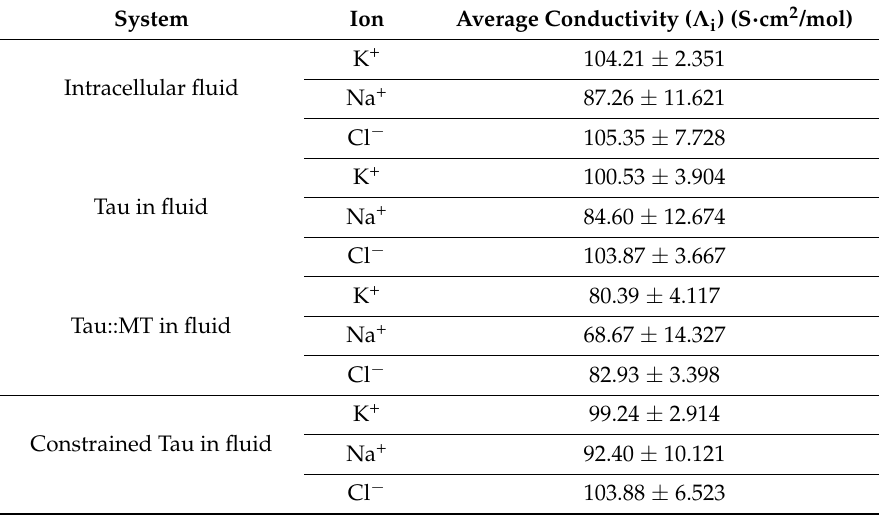
Table 1. Calculated conductivity ( Λ i ) at 310 K, for each ion type in fluid, in all